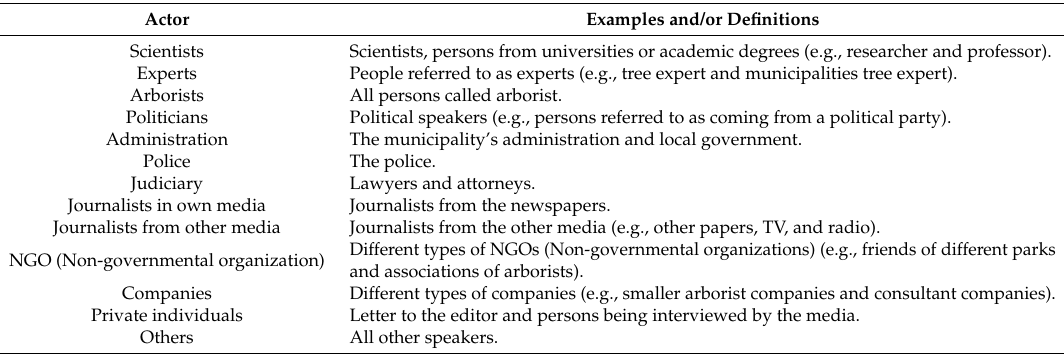
Table 1. Definition of the different